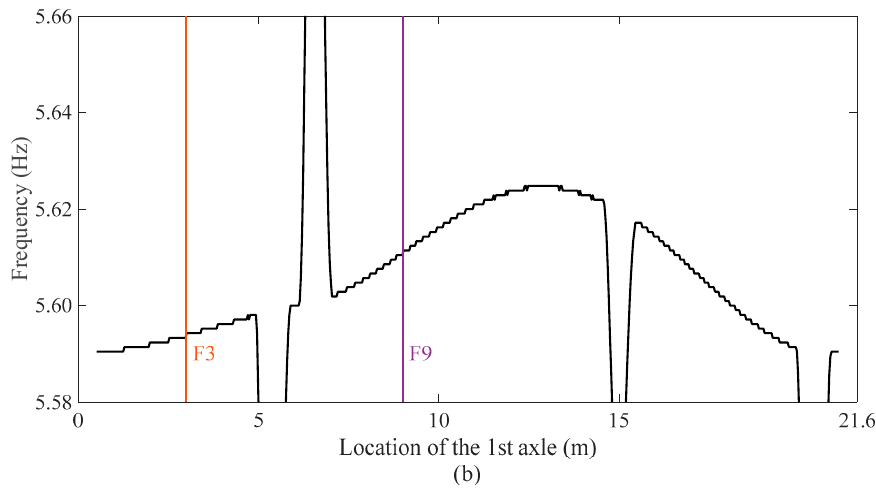
Figure 11. Instantaneous frequencies by STFT vs. location of the 1st axle for scenarios: ( a ) 15% crack at 5 m, and ( b ) 5% crack at 7 m.